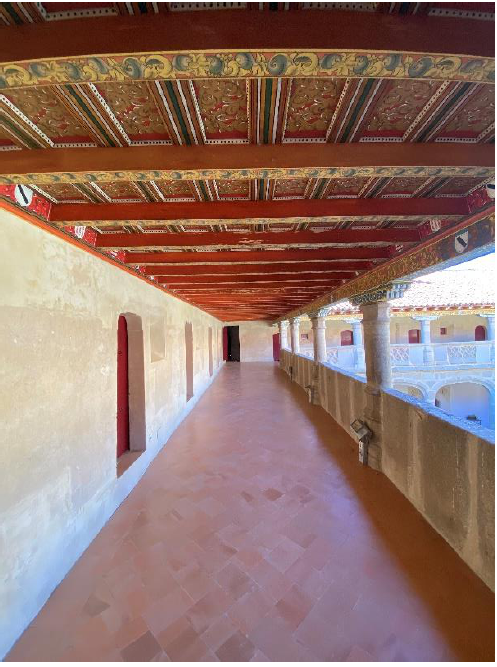
Figure 4 Photo of the galleries of the monastery’s cloisters, 2020.